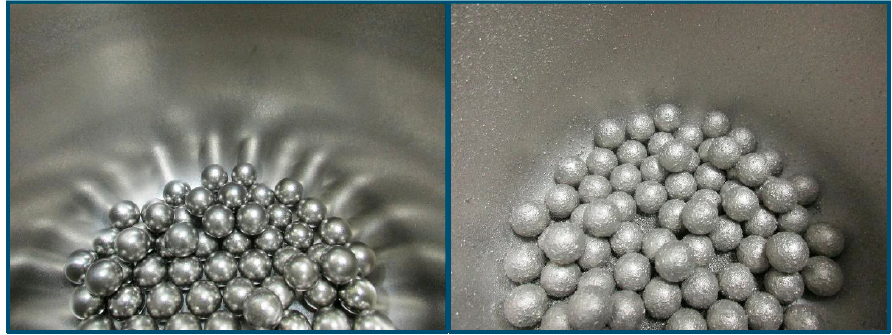
Figure 2. Inside of the milling bowl before ( left ) and after ( right ) the dry milling process of the CoCrFeNi powders milled for 15 h. Apart from the free powder at the bottom, the inside of the bowl still contains significant amount of powder stuck to its walls and to the milling balls, which were removed by 30 min of wet milling. Table 1. Manufacturers and product parameters of powders used for preparation of mechanically alloyed CoCrFeNi alloy.